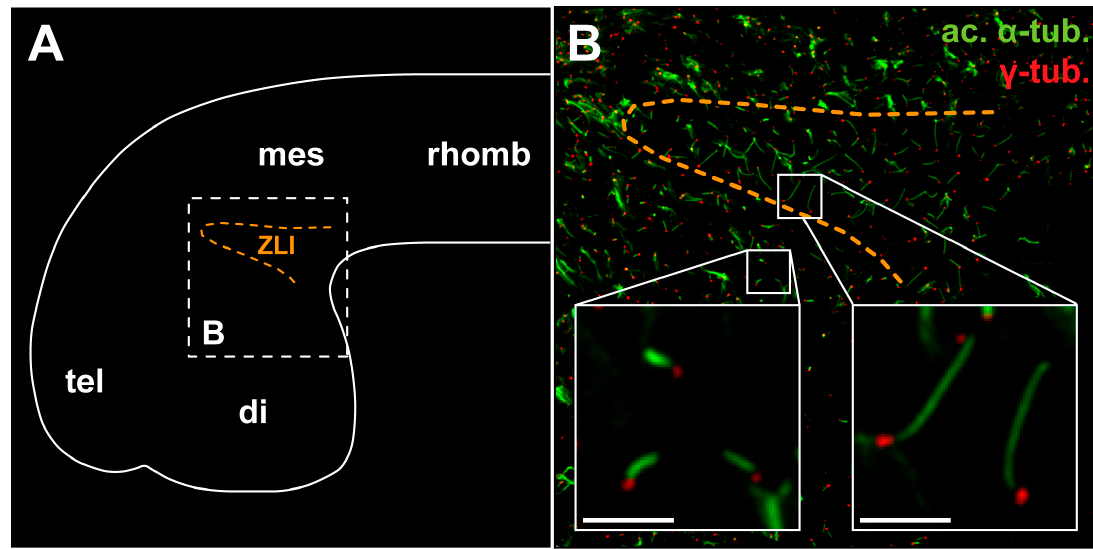
Figure 3. Elongated cilia on the zli. ( A ) Schematic overview of the Xenopus tadpole brain comprised of (from anterior to posterior) telencephalon (tel), diencephalon (di), mesencephalon (mes) and rhombencephalon (rhomb). The position of the zli is indicated by orange dashed line. ( B ) Magnification of area indicated by white dashed line in ( A ). Whole mount immunofluorescence staining on the ventricular surface of a tadpole brain. Antibodies detecting acetylated alpha-tubulin (ac. α -tub.) and gamma-tubulin ( γ -tub.) mark cilia axonemes and basal bodies, respectively. Note that zli cilia are markedly elongated compared to cilia on neighboring cells (scale bars: 5 µ